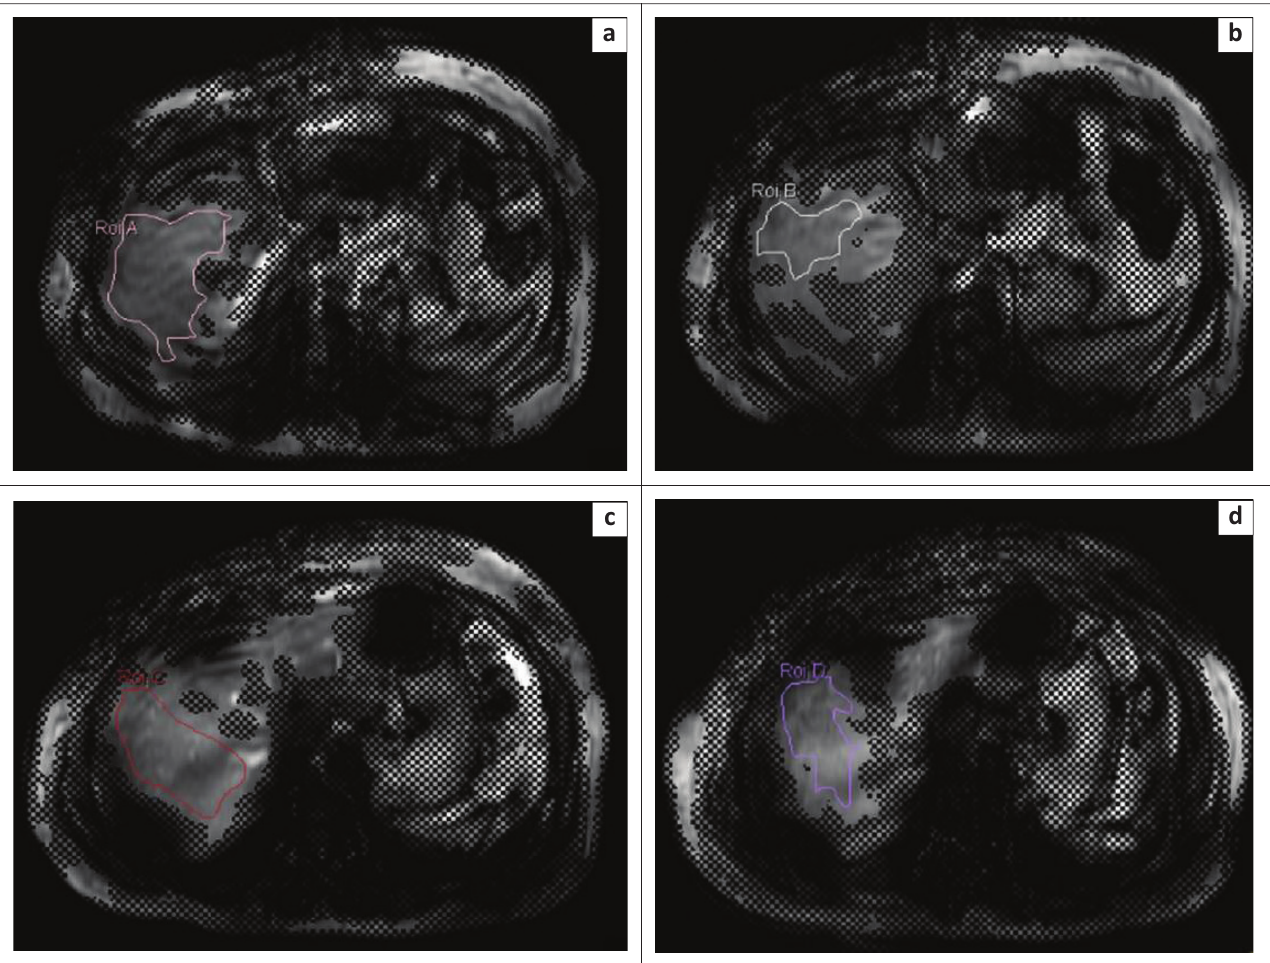
FIG URE 1: Depiction of the measurement of liver stiffness (a–d), by drawing free-hand regions of interest on all four slices of the magnitude images to cover the maximum hepatic parenchyma not covered by the 95 % confidence maps.